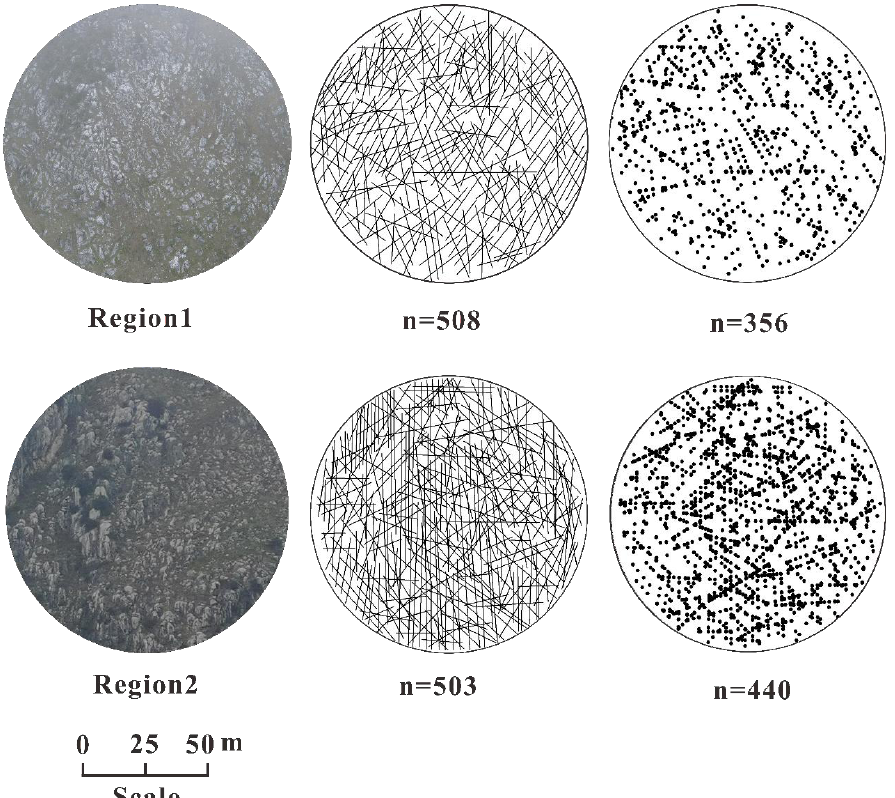
Figure 15. Digital lineament strength and density map (n represents the number and intersections of the lineaments) in measured region 1 and 2.